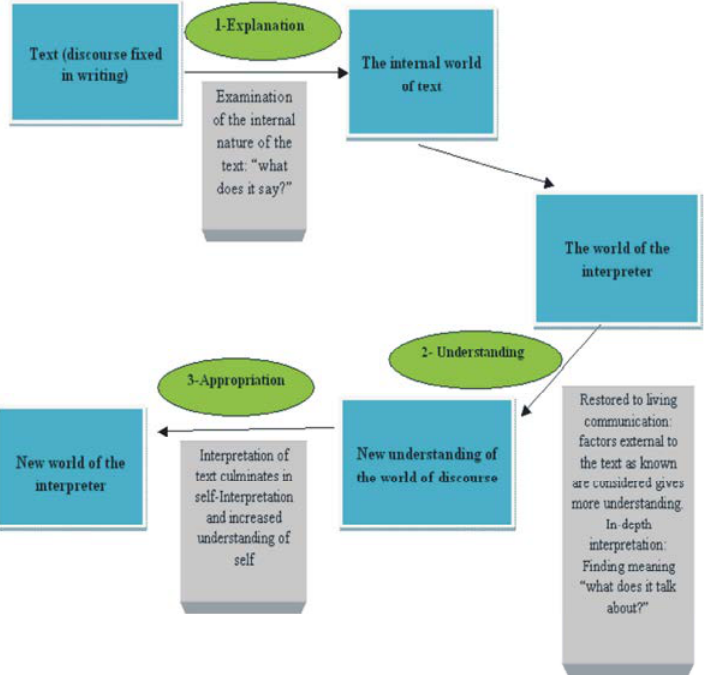
Fig. 1: Ricoeur’s theory of interpretation text necessary cleavage subjective intentions